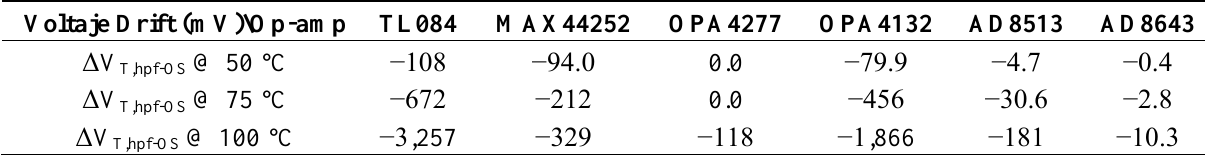
Table 11. Output voltage drifts ΔV 25 °C point of reference.